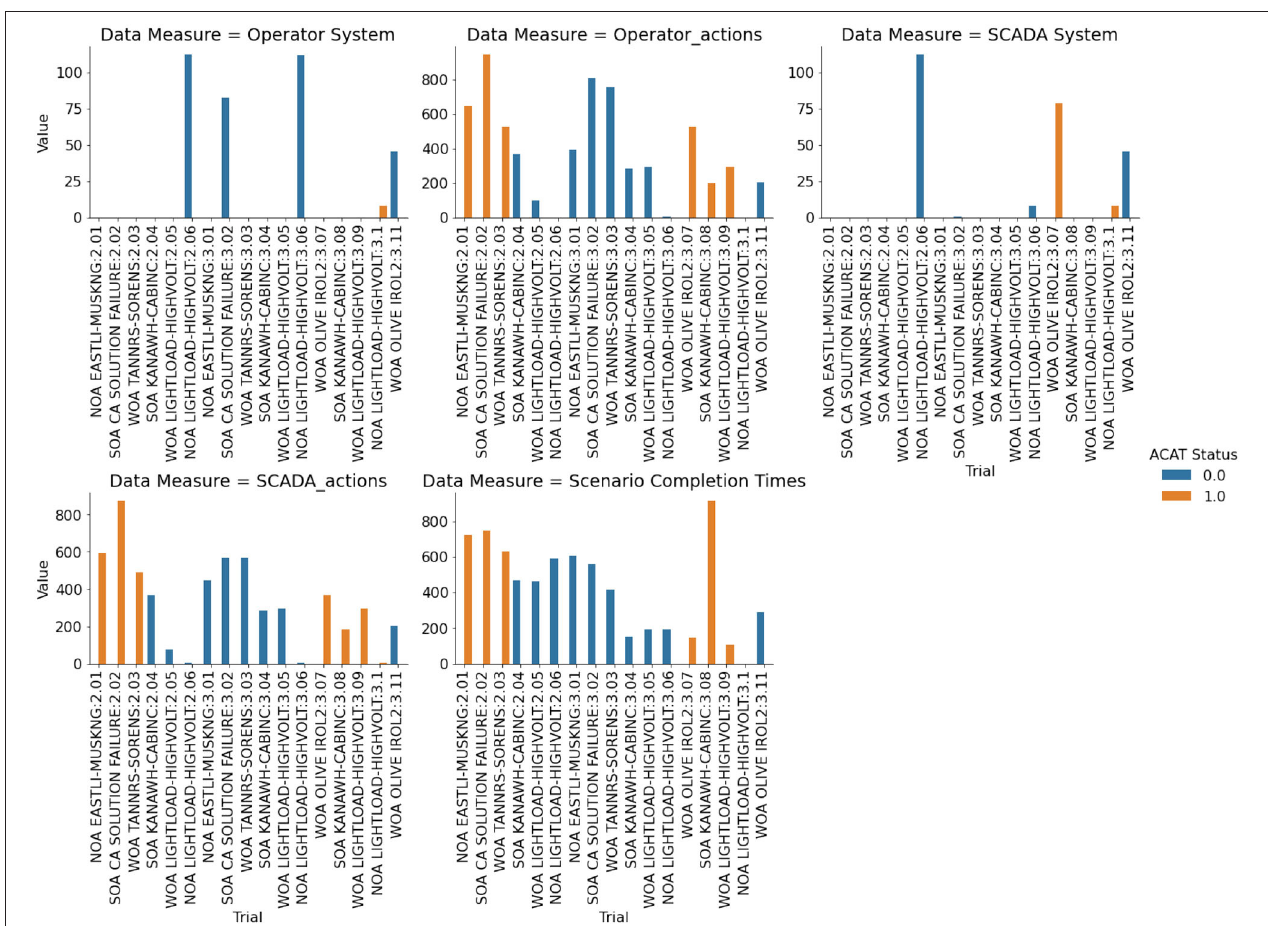
FIGURE 5 | Performance measures computed for each